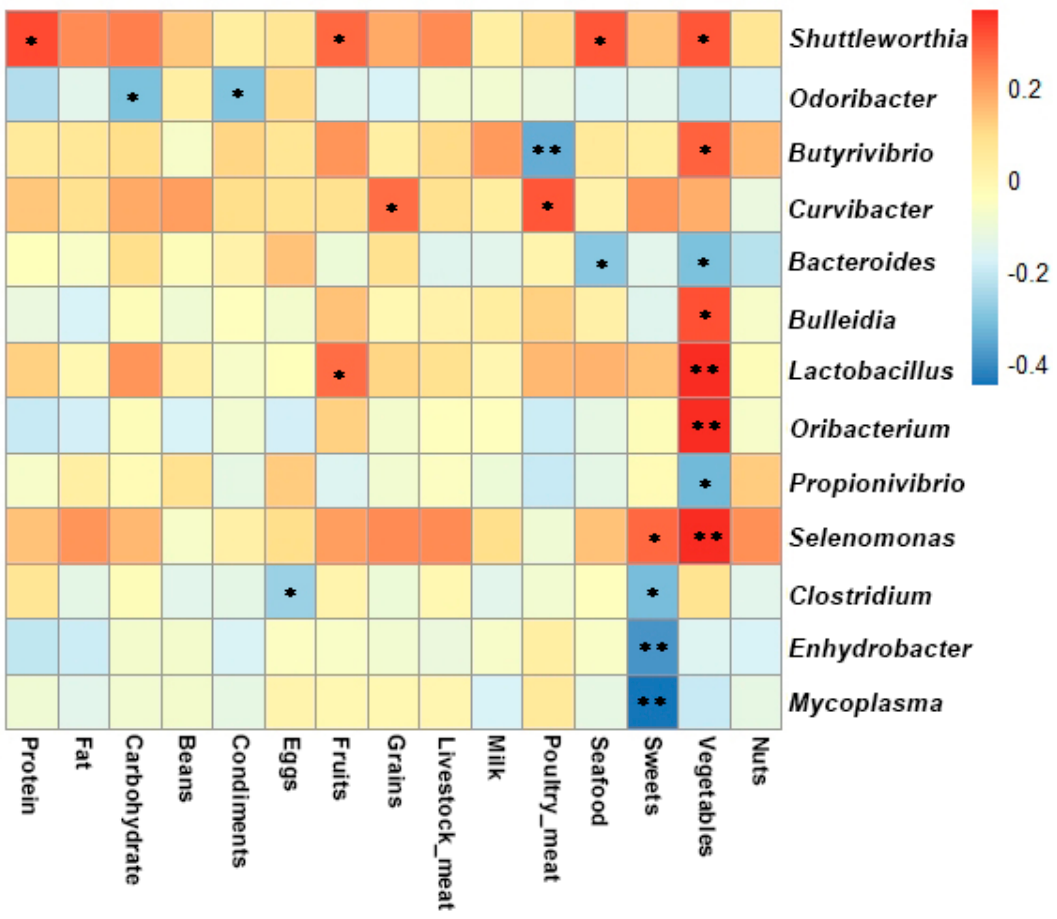
Figure 3. Genus level correlation heatmap between the oral microbiota and dietary intake (* p < 0.05, ** p < 0.01; the p value was calculated using the Pearson correlation).